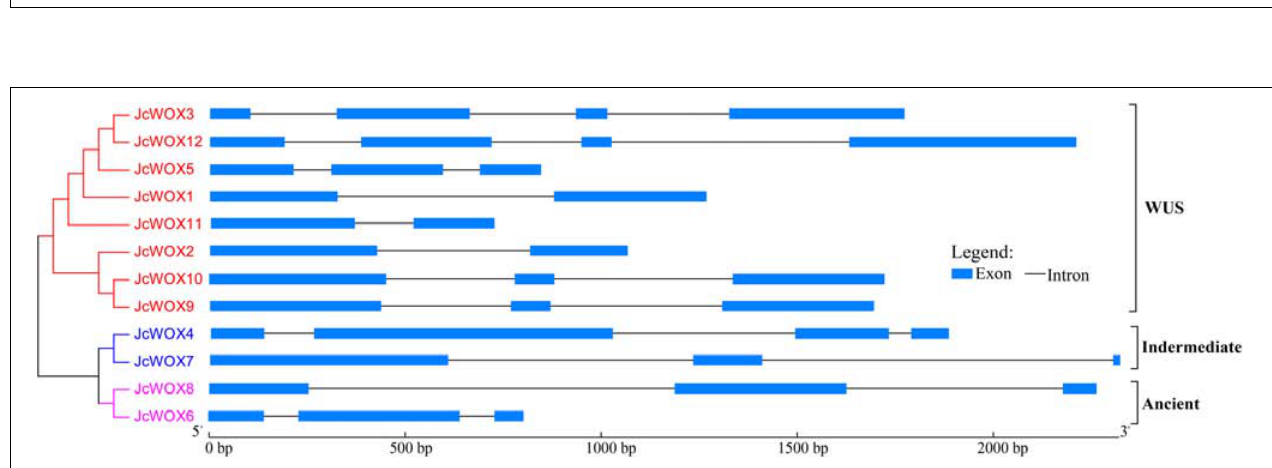
FIGURE 2 | Phylogenetic relationships and gene structure in WOX genes from physic nut. Exons and introns are shown as light blue boxes and thin lines, respectively. The unrooted tree was constructed, using the MEGA6.0 program, by the neighbor-joining method. Gene classes are indicated with different colors.